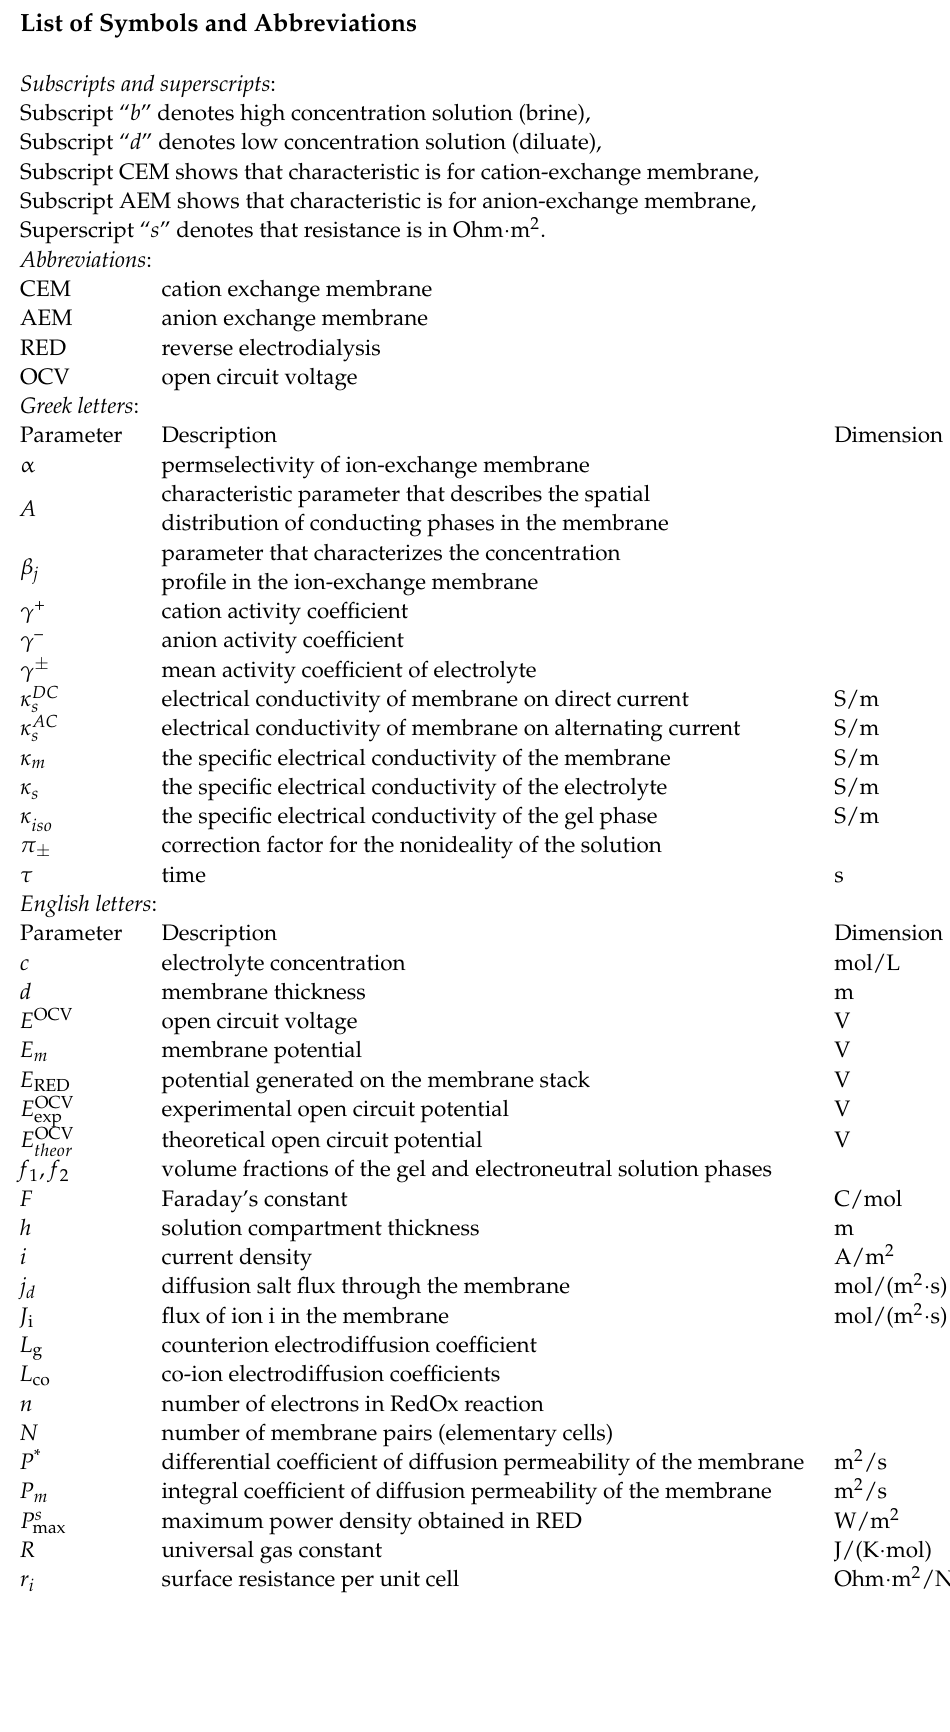
List of Symbols and